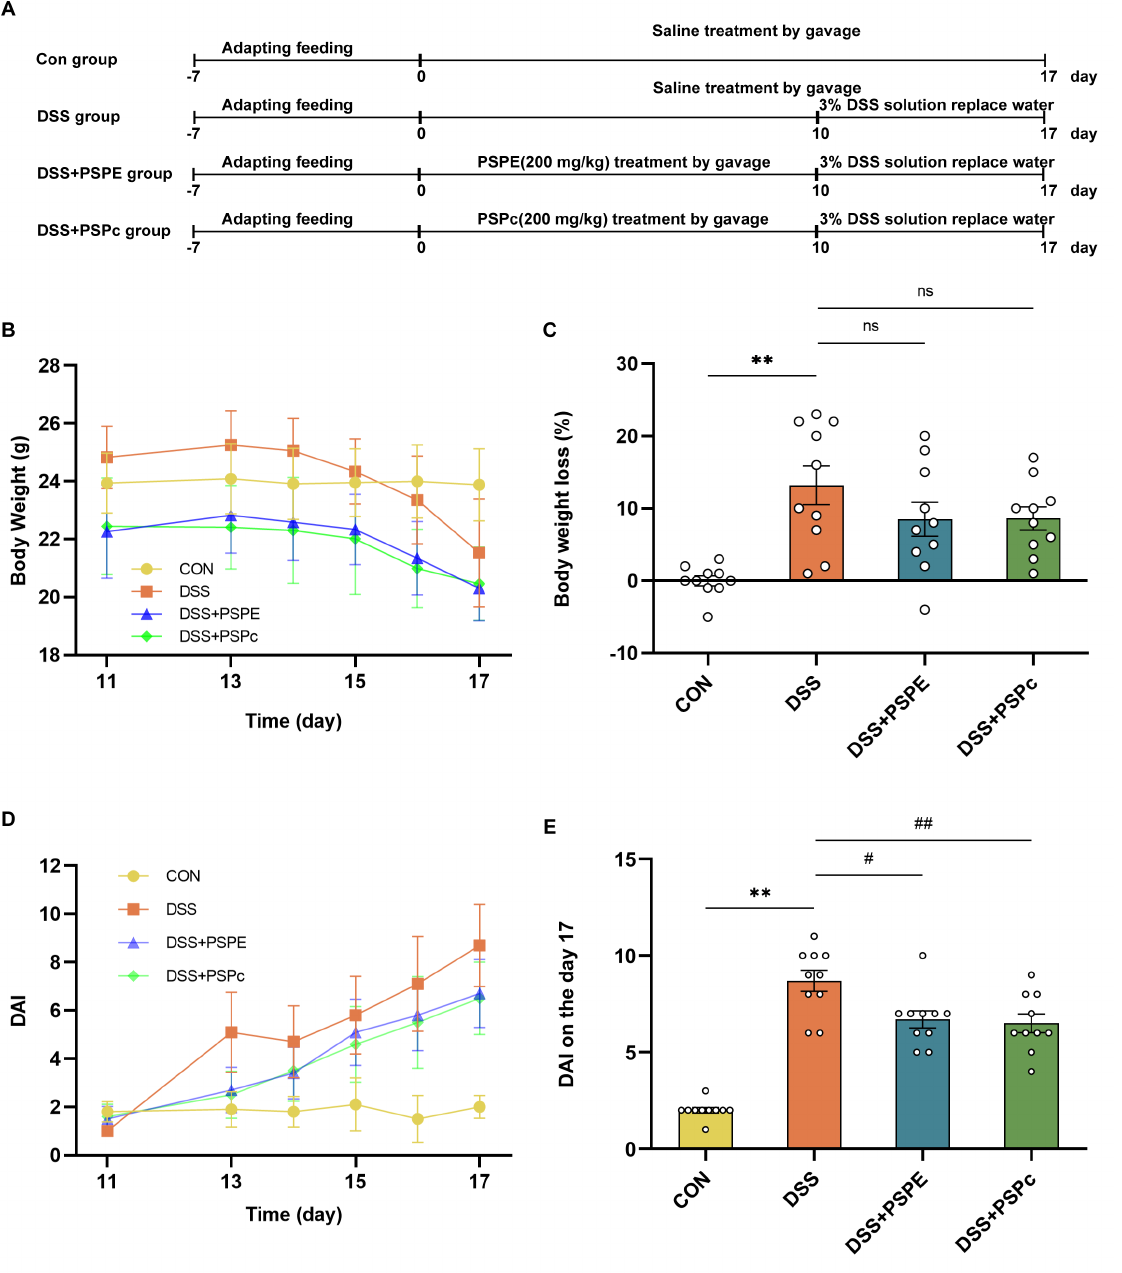
Figure 2. Effect of PSPE and PSPc on the symptoms in the colon tissue of DSS − induced colitis mice. ( A ) Con group: control group ( n = 10 mice); DSS group: DSS alone group ( n = 10 mice); DSS + PSPE group: PSPE 200 mg/kg + DSS group ( n = 10 mice); DSS + PSPc group: PSPc 200 mg/kg + DSS group ( n = 10 mice). Schematic representation of the experimental design; ( B ) body weight during DSS treatment (11th–17th day); ( C ) body weight loss during the DSS treatment ([body weight on 11th day-body weight on 17th day]/body weight on 11th day); ( D ) DAI score during DSS treatment; ( E ) DAI on the seventh day after DSS-induced UC. Data were expressed as mean ± SE ( n = 3 mice). ** p < 0.01, compared with the Con group, # p < 0.05, ## p < 0.01, compared with the DSS group, ns = not significant.